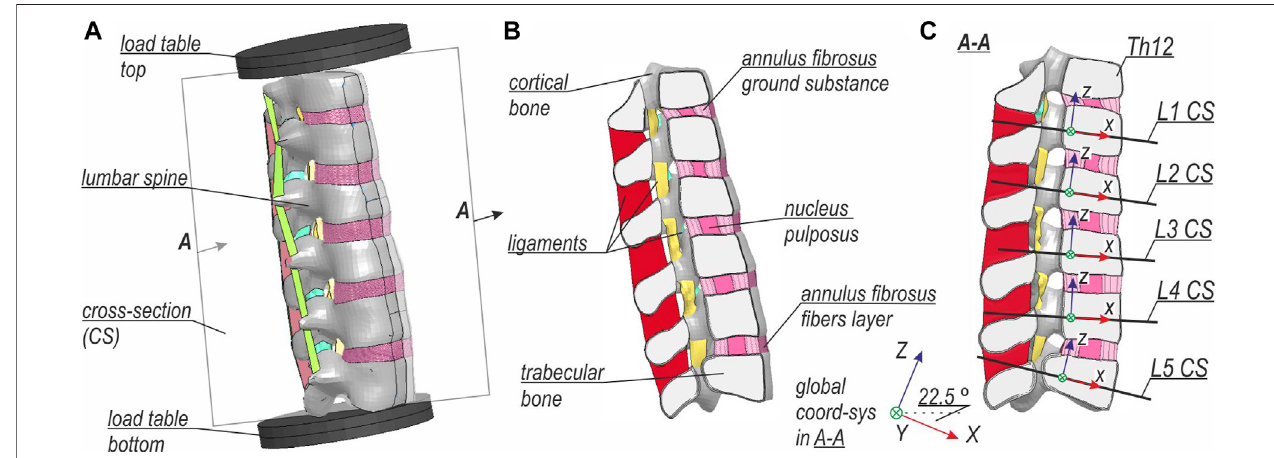
FIGURE 2 | Setup of the detailed lumbar spine FE model: (A) general view, (B) half-section view, and (C) view on cross-sections with global and local coordinate systems.